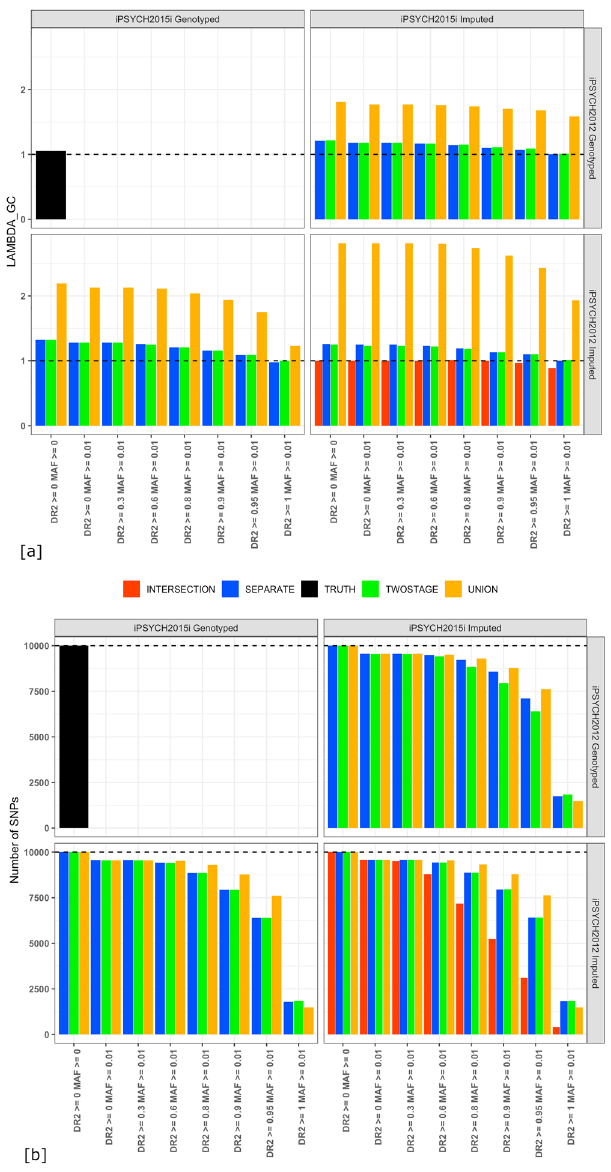
Fig. 5 In fl ation of test statistics shows type-I errors in association studies with imputed data across the four data integration protocols as compared to genotyped variants. a Shows the in fl ation in test statistics represented using lambda genomic control when performing an association test at each of the 10,000 SNPs common to both genotyping arrays masked prior to phasing. Controls of a homogeneous genetic origin were compared between the iPSYCH2012 and iPSYCH2015i cohorts with the genotyping array astheoutcomeatdifferent thresholds ofpost-imputationquality control across the four different data integration protocols (Array genotypes: black bars, intersection protocol: red bars, separate protocol: blue bars, union protocol: yellow bars, two-stage protocol: green bars). The dotted horizontal black line indicates the baseline ƛ gc when the association test was performed using true genotypes from both arrays. Haplotypes were phased using BEAGLE5 phase- states = 560, imputations were done using BEAGLE5.1 with the HRCv1.1 as the reference. b Shows the number of SNPs left after each threshold of post- imputation quality control across the four data integration